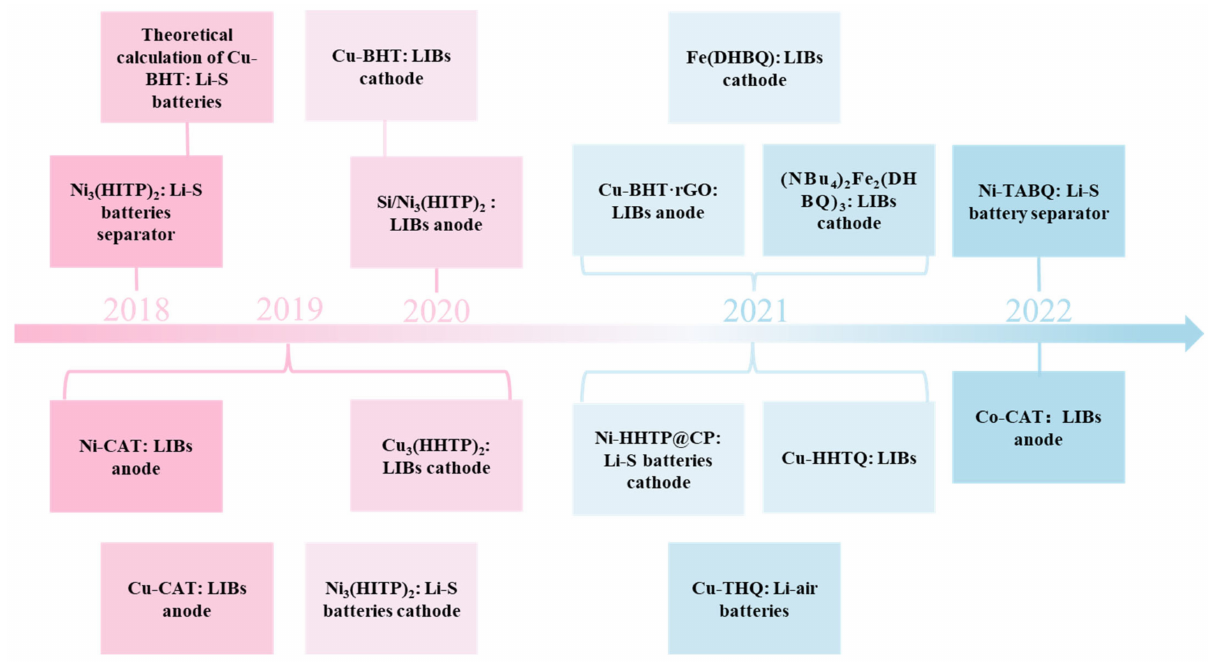
Figure 3. Time axis of c-MOFs application in lithium